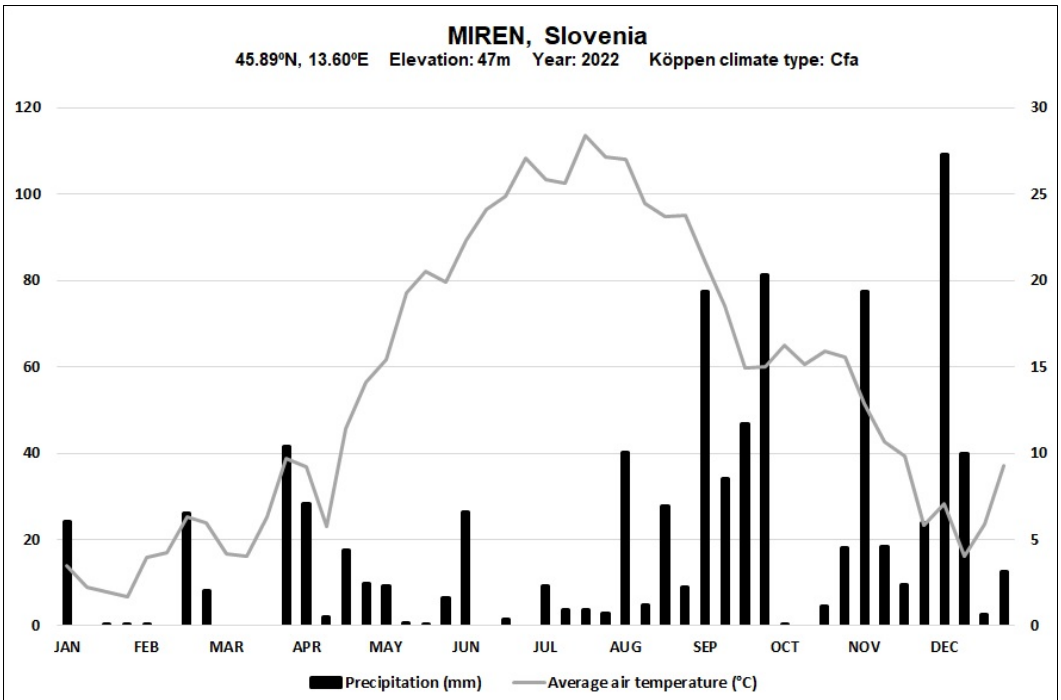
Figure 2. The climatic diagram shows the annual rainfall and air temperature regime. The bars represent average weekly precipitation (mm), and the line is the average weekly air temperature (°C) at the meteorological station Miren (Slovenia) in 2022.